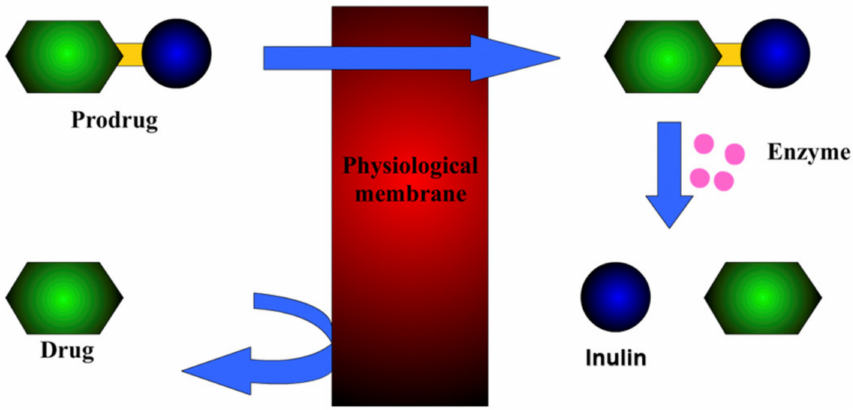
Figure 7. Diagram showing prodrug